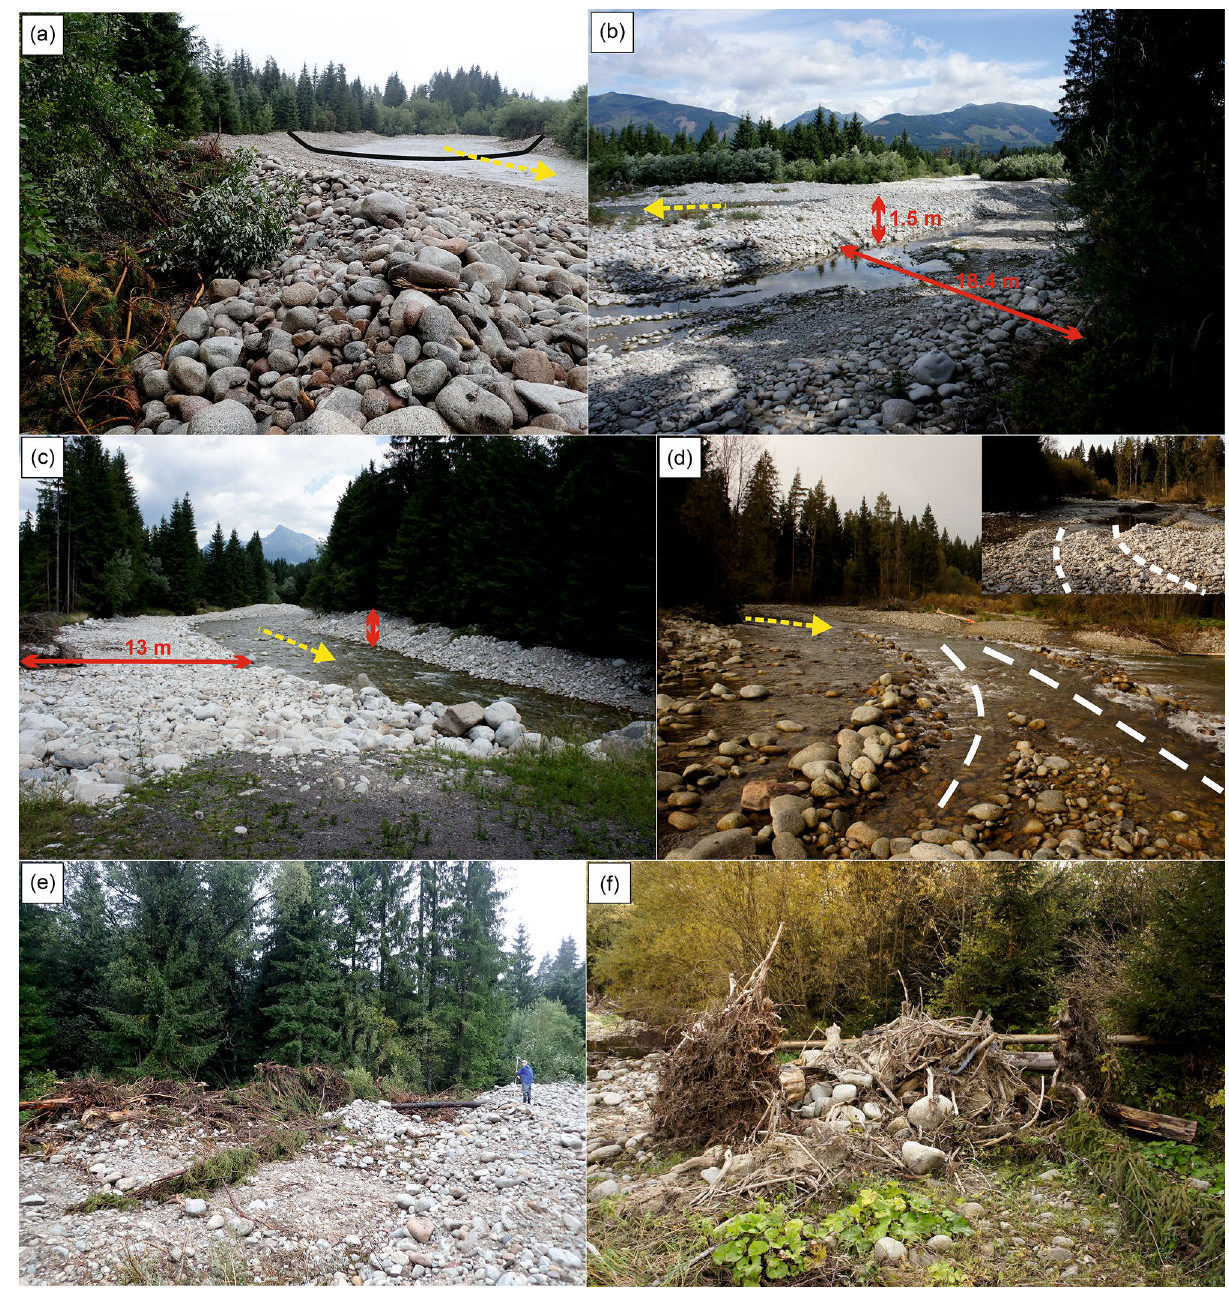
Figure 2. ( a ) Photographic documentation of how gravel has formed into a wide “U”-shaped channel and ( b ) of the artificial formation of backwater surfaces and elevated gravel barriers in the middle of the braidplain area near Pribylina settlement during field reconnaissance in 2018 and 2019. ( c ) We recognized the formation of artificial lateral bar surfaces and elevated gravel banks (marked with red arrows) further upstream at Kokavský Bridge in RR10. ( d ) Visible traces of heavy equipment transfer (white dashed lines) at two sites between the individual treated river reaches between Vavrišovo and Pribylina settlements. ( e ) On the edges of riverbanks, we documented the rolling up of large woody debris mass ( f ) mixed with granite boulders. Yellow arrow represents the flow direction (photo: Anna Kidová; A, E, F: 13.8.2018; B, C: 17.7.2019; D: